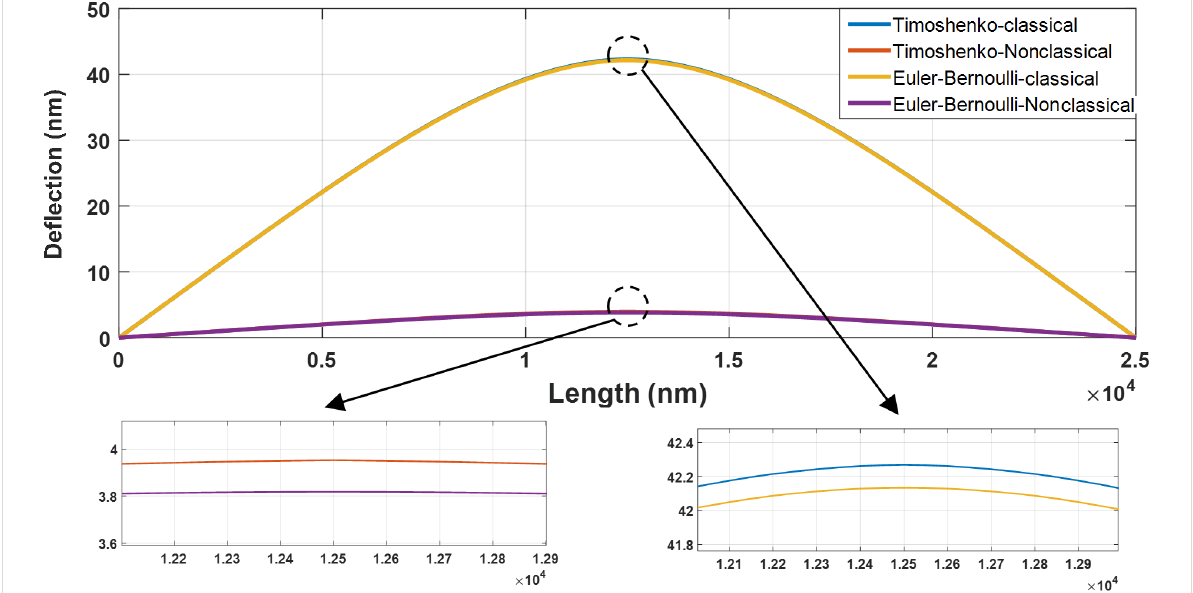
Figure 7: Classical and nonclassical modeling of the deflections of a cylindrical gold nanoparticle (length = 25 µm and aspect ratio = 30) based on the four models of classical Euler–Bernoulli, classical Timoshenko, nonclassical Euler–Bernoulli and nonclassical Timoshenko.